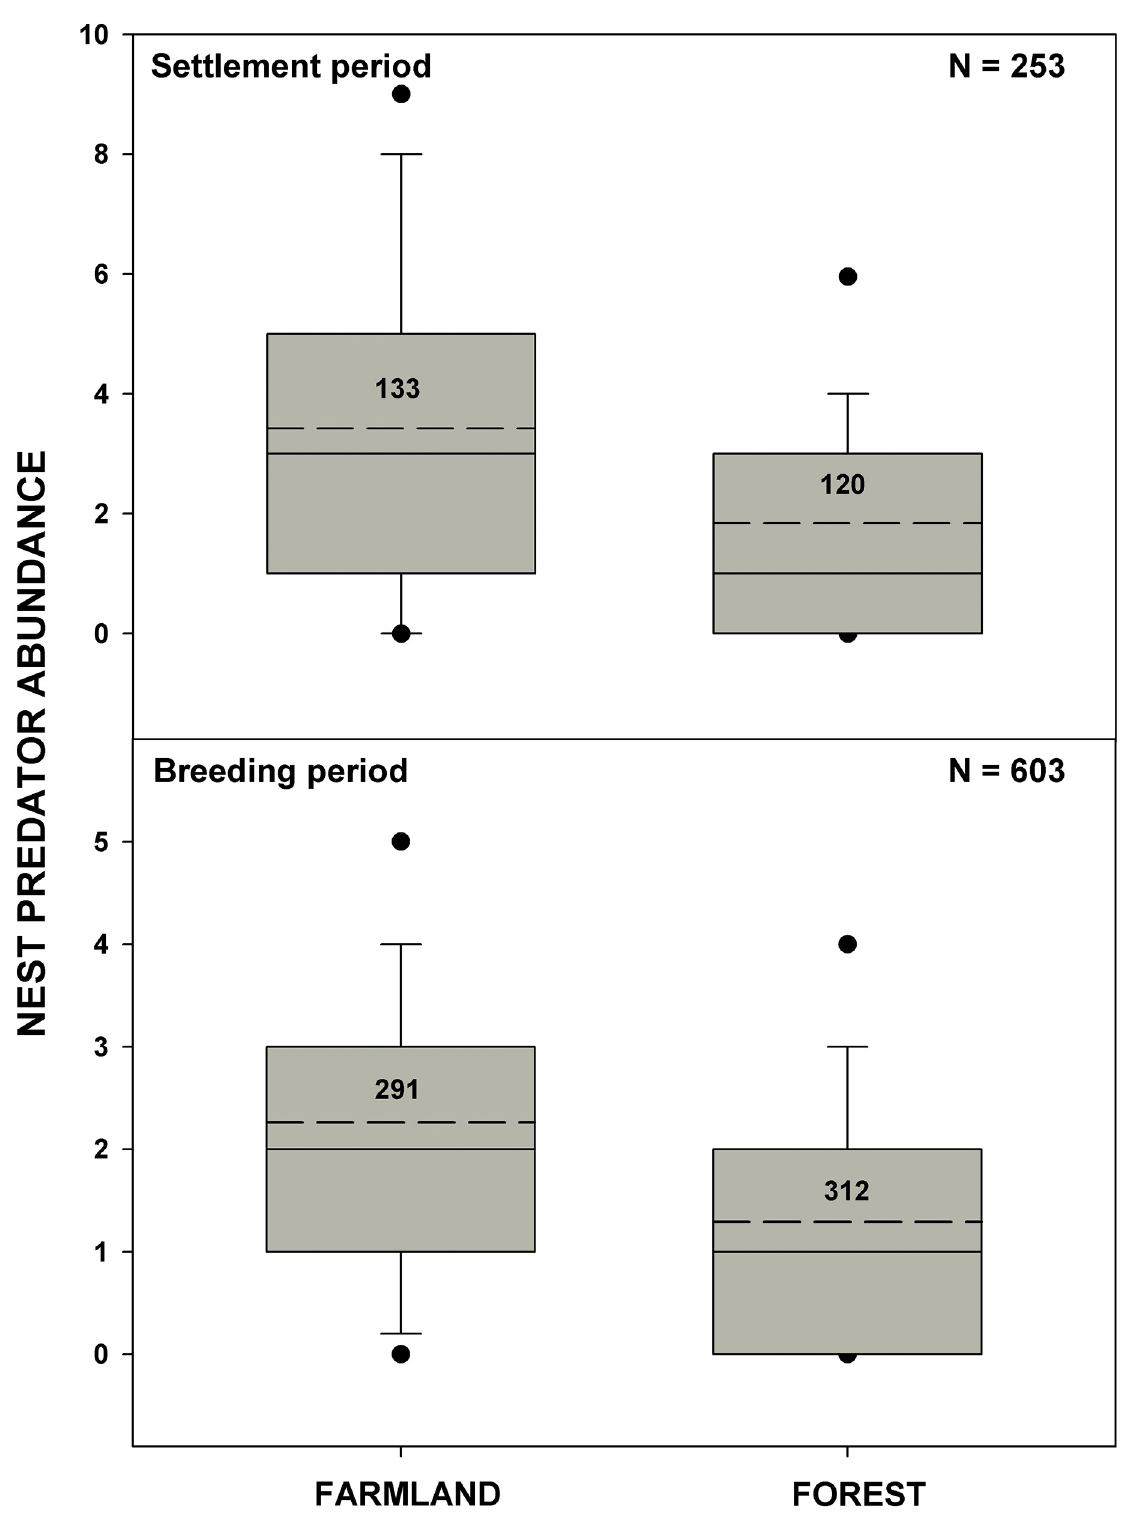
Fig 1. Nest predator abundance in farmland and forest. Nest predator abundance is the number of Jays, Magpies and Crows detected during the point count survey in shrike territories within farmland and forest habitats during the period of shrike settlement and breeding. Box-and-whisker plots represent 5 th and 95 th percentiles [ ┴ and ┬ ], min-max [ (cid:129) ], mean [--] and median [ − ]) values. Sample sizes refer to the number of corvid point counts. doi:10.1371/journal.pone.0144098.g001 PLOS ONE | DOI:10.1371/journal.pone.0144098 December 1,